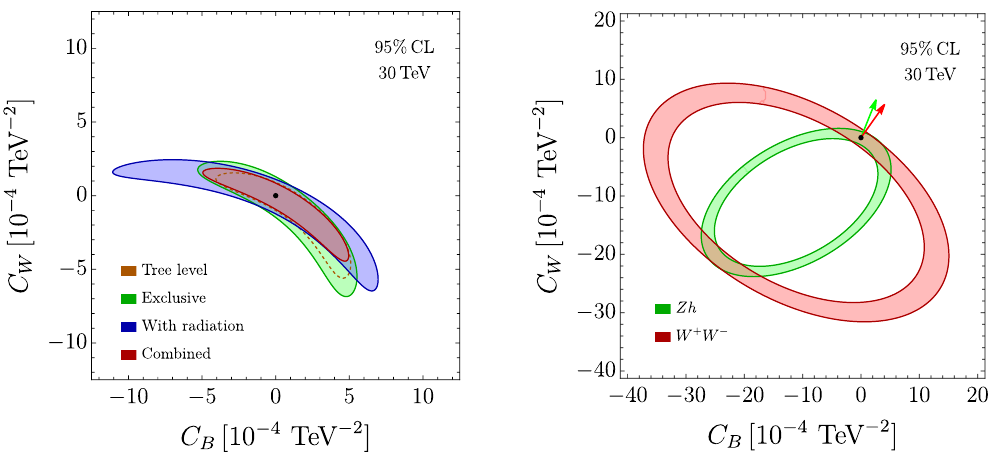
Figure 7. Left: 95% sensitivity contours in the ( C B , C W ) plane at the 30 TeV muon collider. A second allowed region, not shown in the figure, can be eliminated by other measurements [7]. Right: Zh and WW likelihood contours at tree-level. Notice that the ellipses for WW and Zh are tangent in two points, one being the SM, the other being the point where the amplitudes have the same magnitude as in the SM but opposite